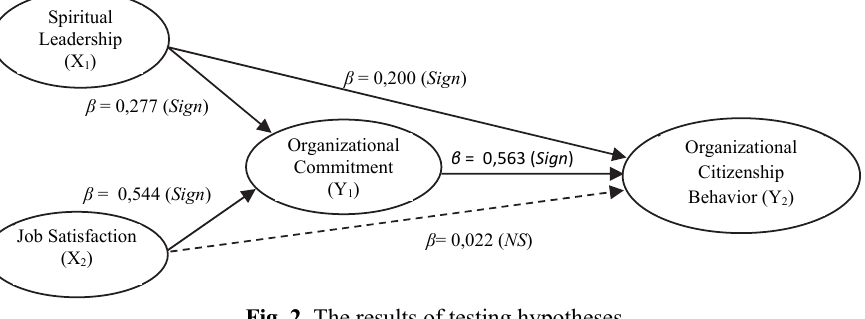
Fig. 2. The results of testing